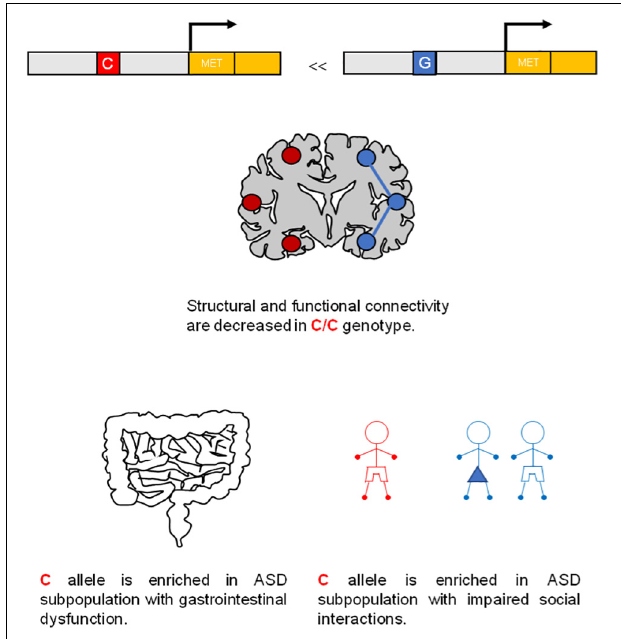
FIGURE 3 | MET gene is a risk factor for autism spectrum disorder (ASD). A common C allele (rs1858830 “C”) on MET promoter region is a risk factor for